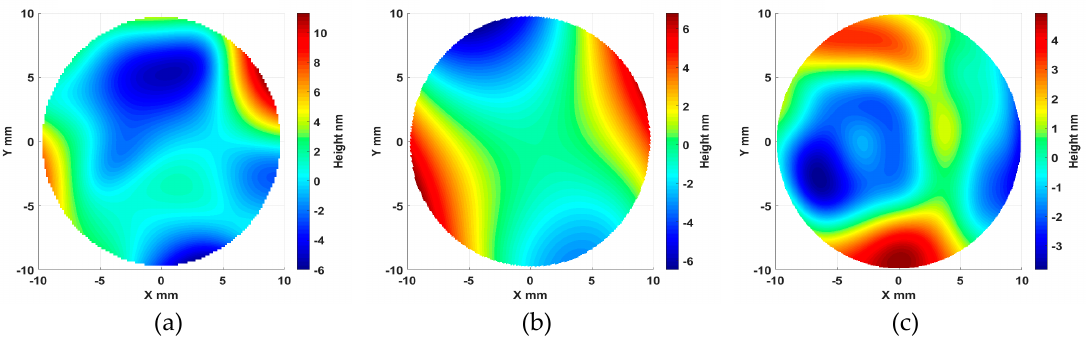
Figure 16. Dispersed reference interferometry (DRI) on-machine measurement ( a ), kinematics error map ( b ), and Fisba measurement of the optically flat mirror ( c ).